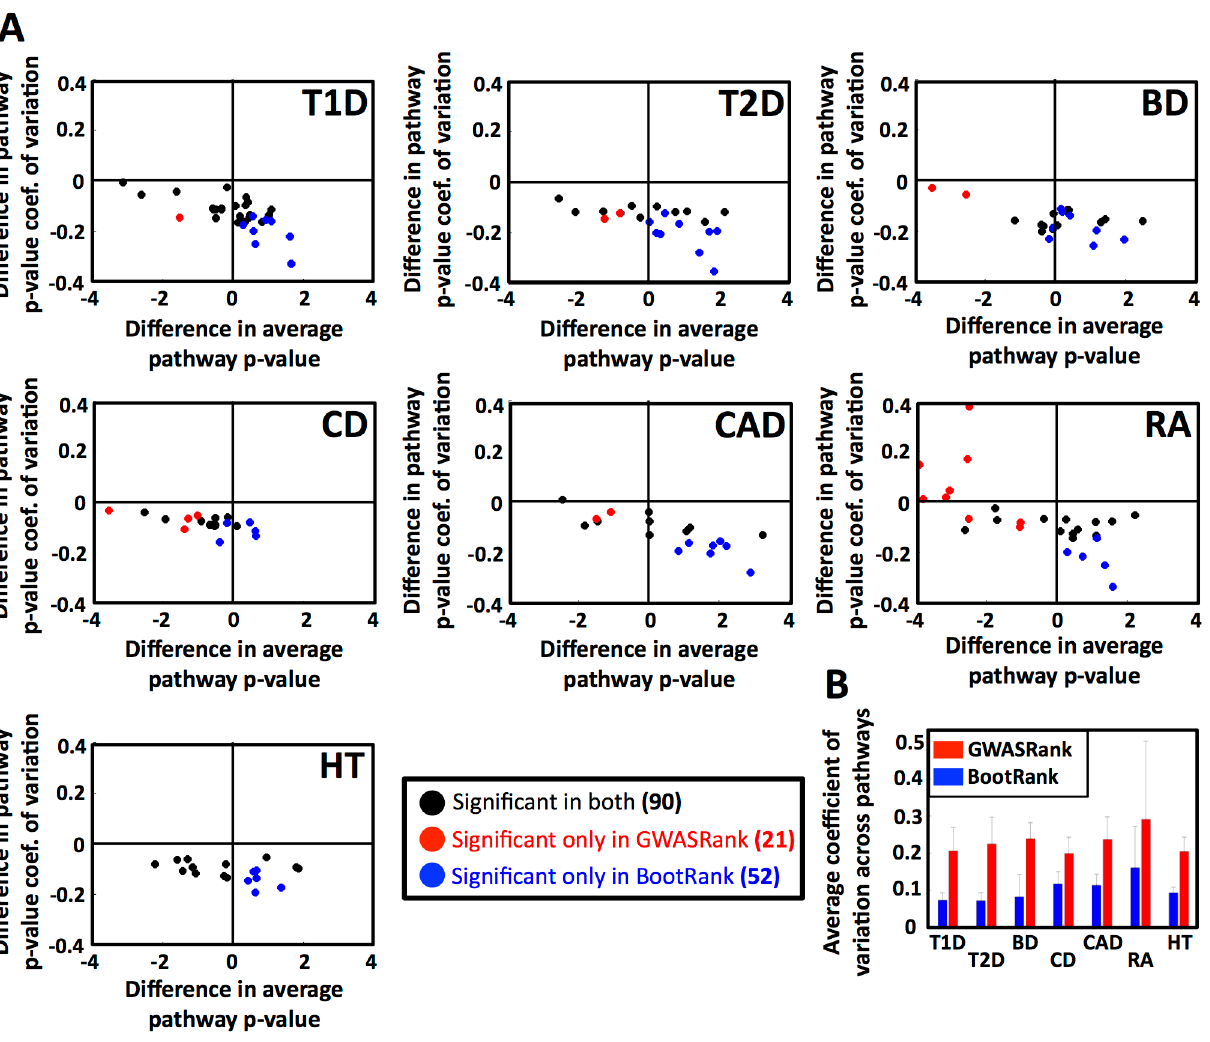
Figure 2. BootRank reduces noise in p-value pathway enrichment scores and detects more enriched pathways. (a) For each disease (T1D, Type 1 diabetes; T2D, Type 2 diabetes; CD, Crohn’s disease; CAD, coronary artery disease; BD, bipolar disorder; RA, rheumatoid arthritis; HT, hypertension), shown are the differences in the average (x-axis) and coefficient of variation (y-axis) of the enrichment p-values of all significantly enriched KEGG pathways. (b) The mean noise (measured as coefficient of variation) of pathway enrichment p-values are shown for all diseases for GWASRank (red) or BootRank (blue).